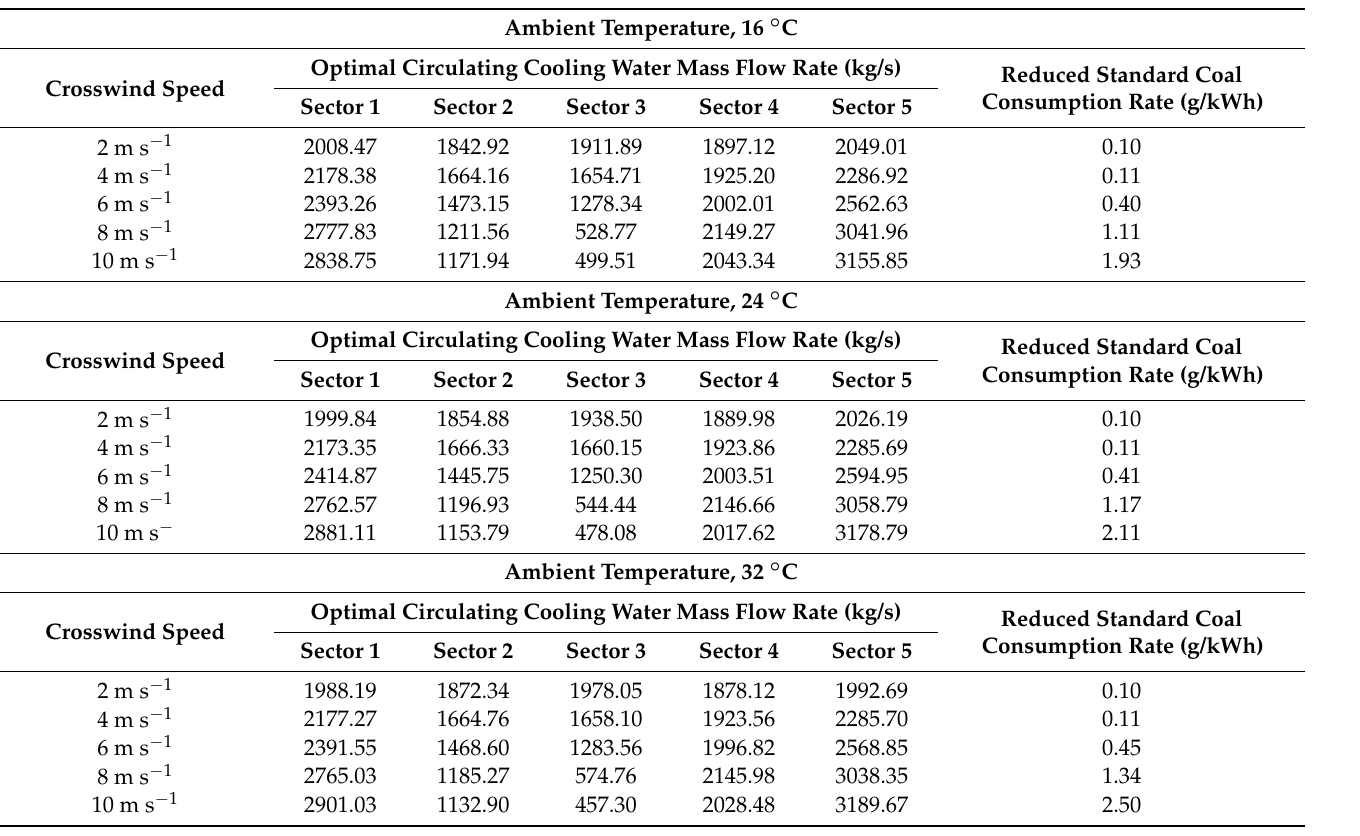
Table 2. Optimal circulating cooling water distributions and saved standard coal consumption